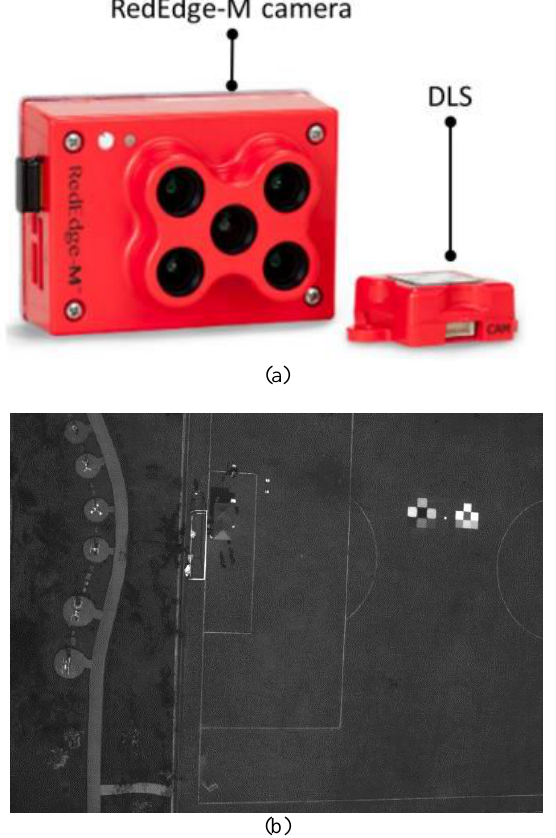
Figure 2. (a) The multispectral camera and irradiance sensor. (b) Blue band image of Mica-Sense camera.